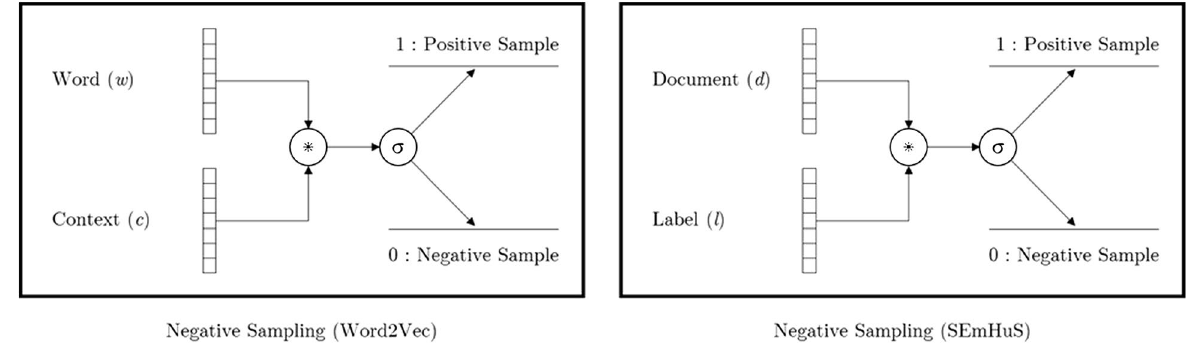
Fig. 2 Negative Sampling in Word2Vec vs.